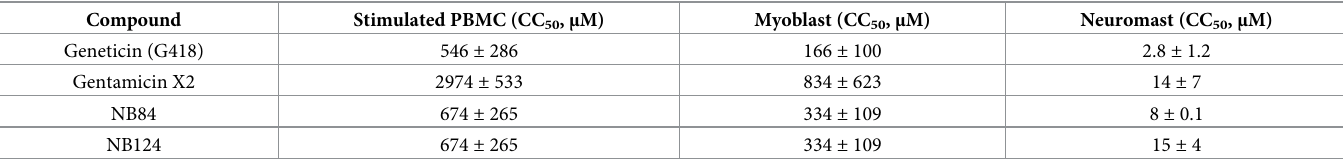
Table 2. Aminoglycoside toxicity.